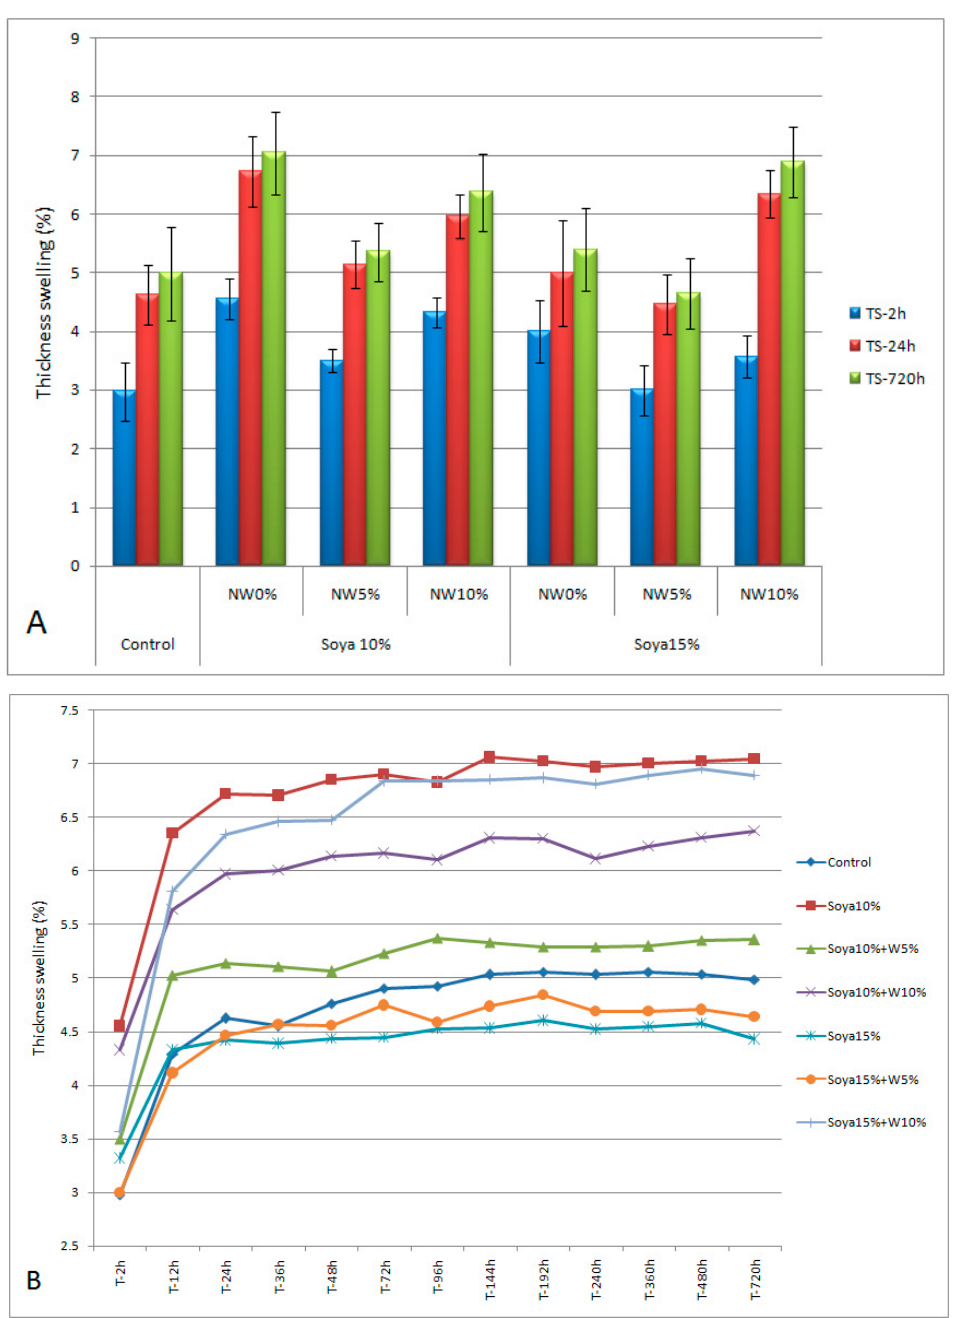
Figure 10. Thickness swelling (%) in three-layer plywood panels (Soy% = soy flour content; W% = wollastonite content; TS = thickness swelling).